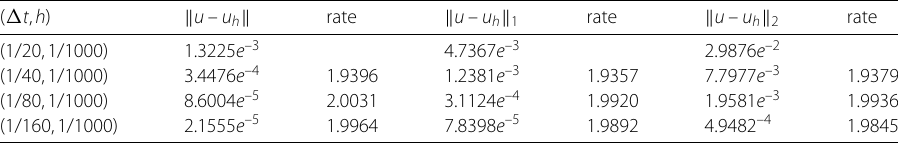
Table 2 The errors for different time step (cid:3) t at t = 1 and convergence orders